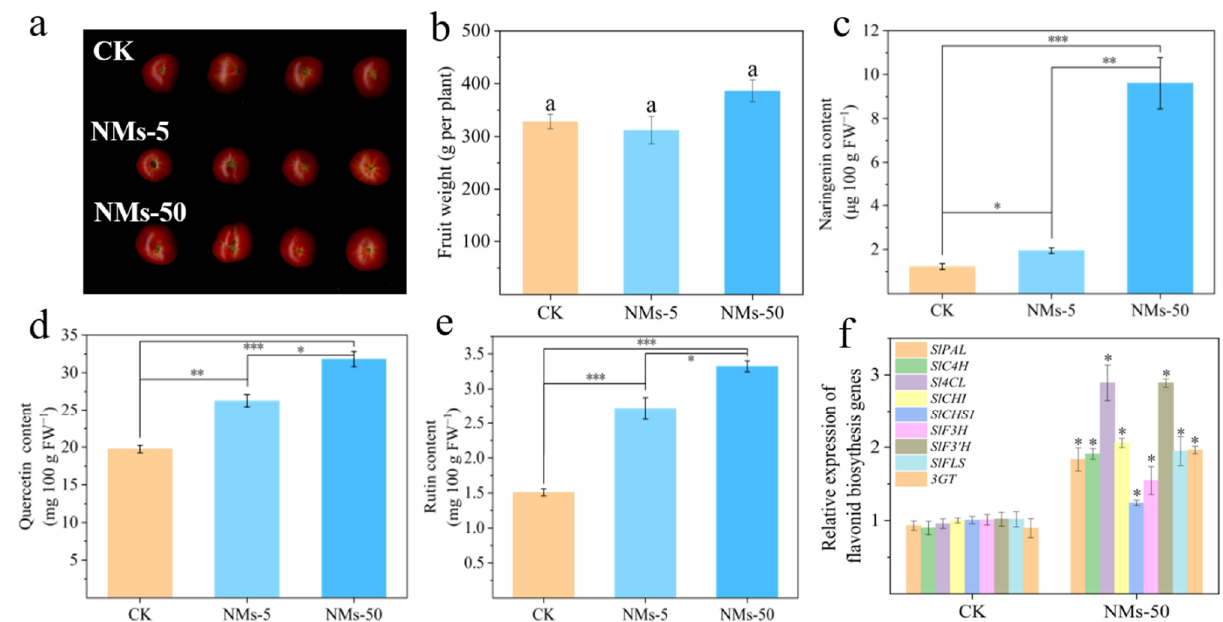
Figure 2. ( a ) Tomato fruits upon 5 and 50 mg kg − 1 Fe 7 (PO 4 ) 6 NMs; ( b ) total fruit yield; ( c – e ) content of naringenin ( c ), quercetin ( d ) and rutin ( e ) in red mature fruits; ( f ), relative expression of flavonoids synthesis genes in tomato fruits. Letters of “a” in ( b ) represent no significance between treatments. Asterisk quantity represents significance as following: “*” for 0.01 < p < 0.05, “**” for 0.001 < p < 0.01 and “***” for p < 0.001.